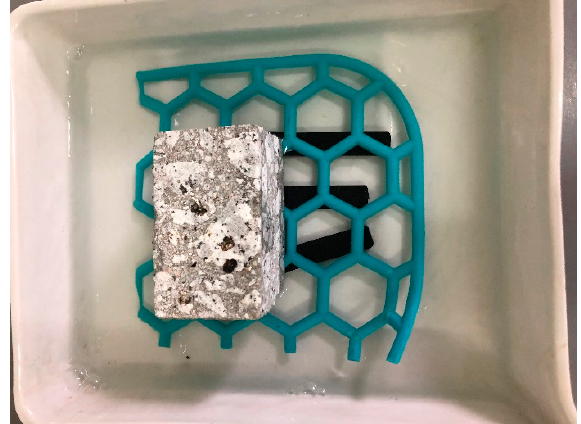
Figure 15. Plastic samples immersed in aviation fuel.